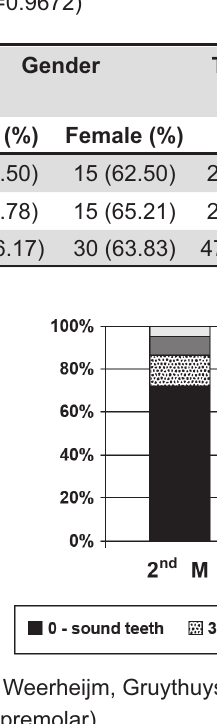
Table 3- Frequency of different clinical aspects of teeth with enamel-dentin caries related to tooth group (p=0.5)